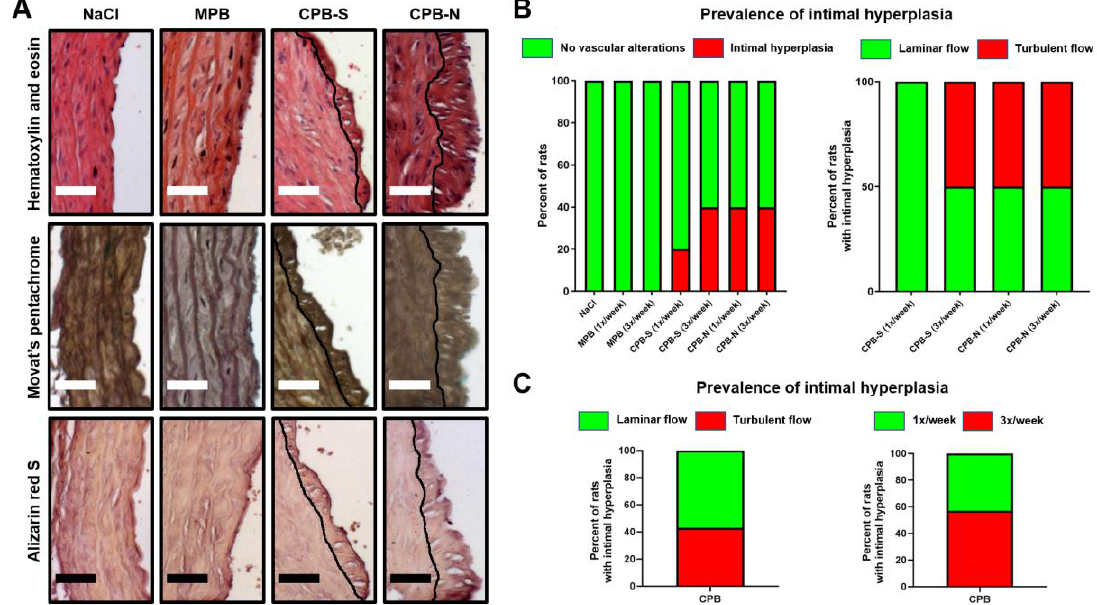
Figure 1. Histological analysis of the intact aortas of normolipidemic Wistar rats who underwent regular (1/3 times a week) tail vein injections of either physiological saline (NaCl), innocuous magnesium phosphate bions (MPB) or spherical (CPB-S)/needle-shaped (CPB-N) calcium phosphate bions. ( A ) Hematoxylin / eosin and Movat’s pentachrome stainings demonstrate visible neointima (demarcated from the media by the black line) in the aortas exposed to CPB-S, or CPB-N but not MPB or NaCl. Negative alizarin red S staining underlines the absence of calcium deposits suggestive of endothelial injury rather than osteogenic transition as a major pathogenic effect of CPBs. Scale bar = 50 µm, close-ups at 200× magnification. ( B ) Quantitative analysis of intimal hyperplasia prevalence reveals that, in contrast to NaCl and MPB, CPB-S and CPB-N cause neointimal formation in 3/10 (30%) and 4/10 (40%) animals, respectively, regardless of the blood flow pattern. ( C ) Pooled quantitative